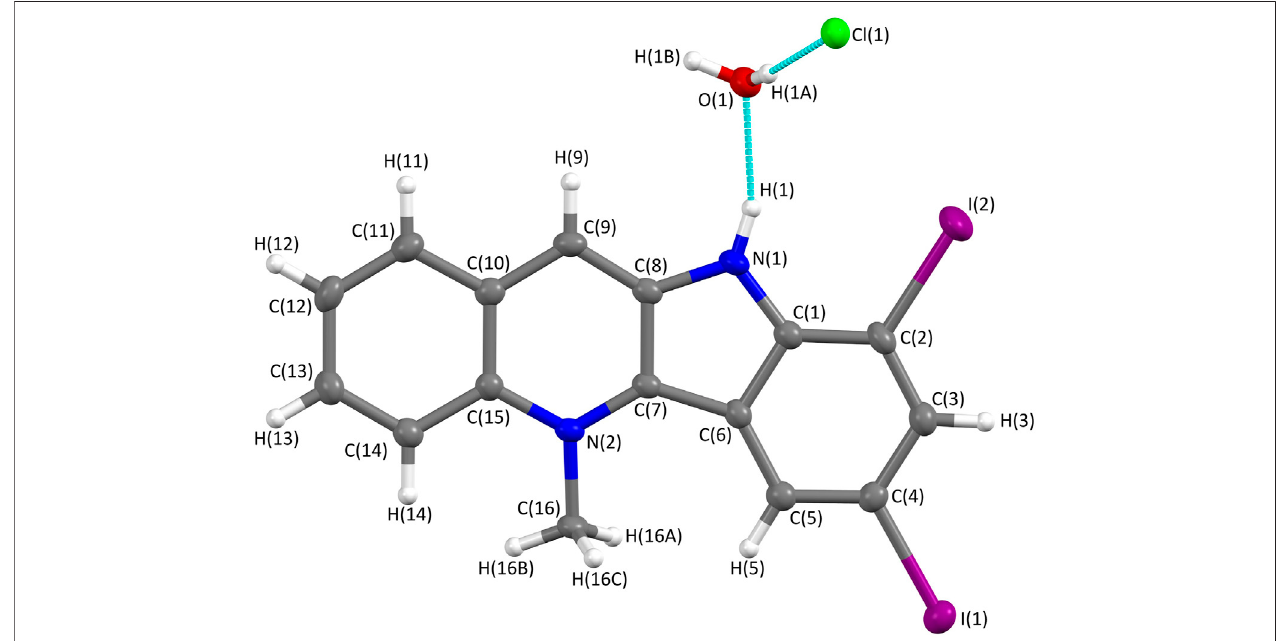
FIGURE4| Molecularstructureof7,9-diiodocryptolepine( 6 )determinedfromX-raysingle-crystaldiffractionusingMoK α radiation.Thestructurewassolvedwithin the Olex2 system using SHELXT and re fi ned using SHELX with an R -factor of 0.027, showing a high level of agreement between the re fi ned structure and the observed data. The crystal structure con fi rms 7, 9-diiodo-substitution of the indole ring; the protonation of nitrogen N (1) and the presence of a chloride anion indicate the hydrochloride salt; one molecule of water is associated with each molecule of 6 .